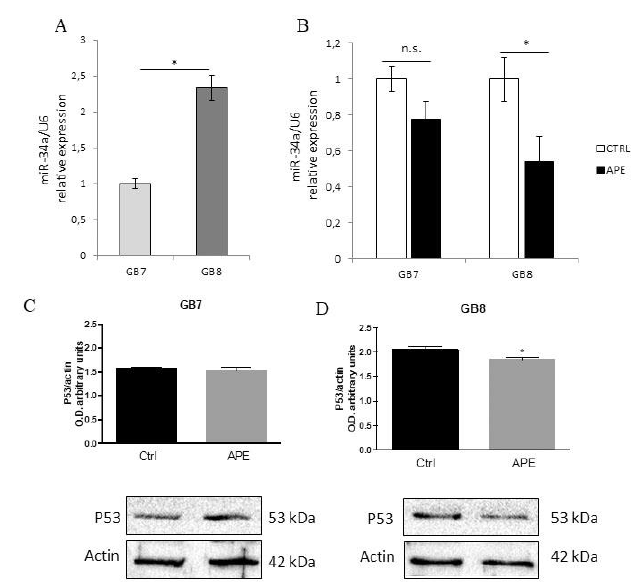
Figure 10. qRT-PCR analysis for miR-34a-5p expression in GB7 and GB8 cells. ( A ) miR-34a-5p levels in untreated GB7 or GB8 cultures. MiRNA relative expression in GB7 was set as one and snRNA U6 used as an internal standard. Data are expressed as the average ± SEM. (N = 3, * p ≤ 0.05, t-test). ( B ) miR-34a-5p levels in untreated (CTRL) or APE-treated (100 µ M for 24 h) GB7 or GB8 cells. For each cell line, miRNA relative expression in CTRL samples was set as one and snRNA U6 used as an internal standard. Data are expressed as the average ± SEM. (N = 3, * p ≤ 0.05, t-test). Western blot analysis of p53 expression in GB7 ( C ) and GB8 ( D ) cells in absence (ctrl) and presence of 100 µ M APE (48 h). The graphs above report the densitometric analysis of the p53 immunoreactive bands normalized with the bands of the reference protein β -actin. The data are the average ± SEM of three independent experiments (t-test; * p <